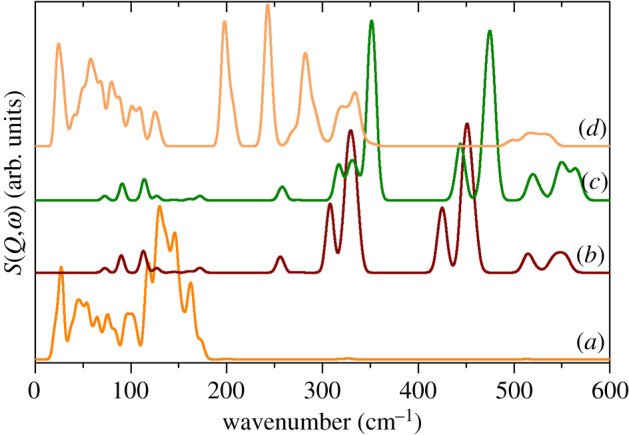
Pseudo-INS spectra of the modes that involve metal ion motion. (a) natK(CH3SO3), (b) 7Li(CH3SO3), (c) 6Li(CH3SO3) and (d) ‘7K(CH3SO3)’.